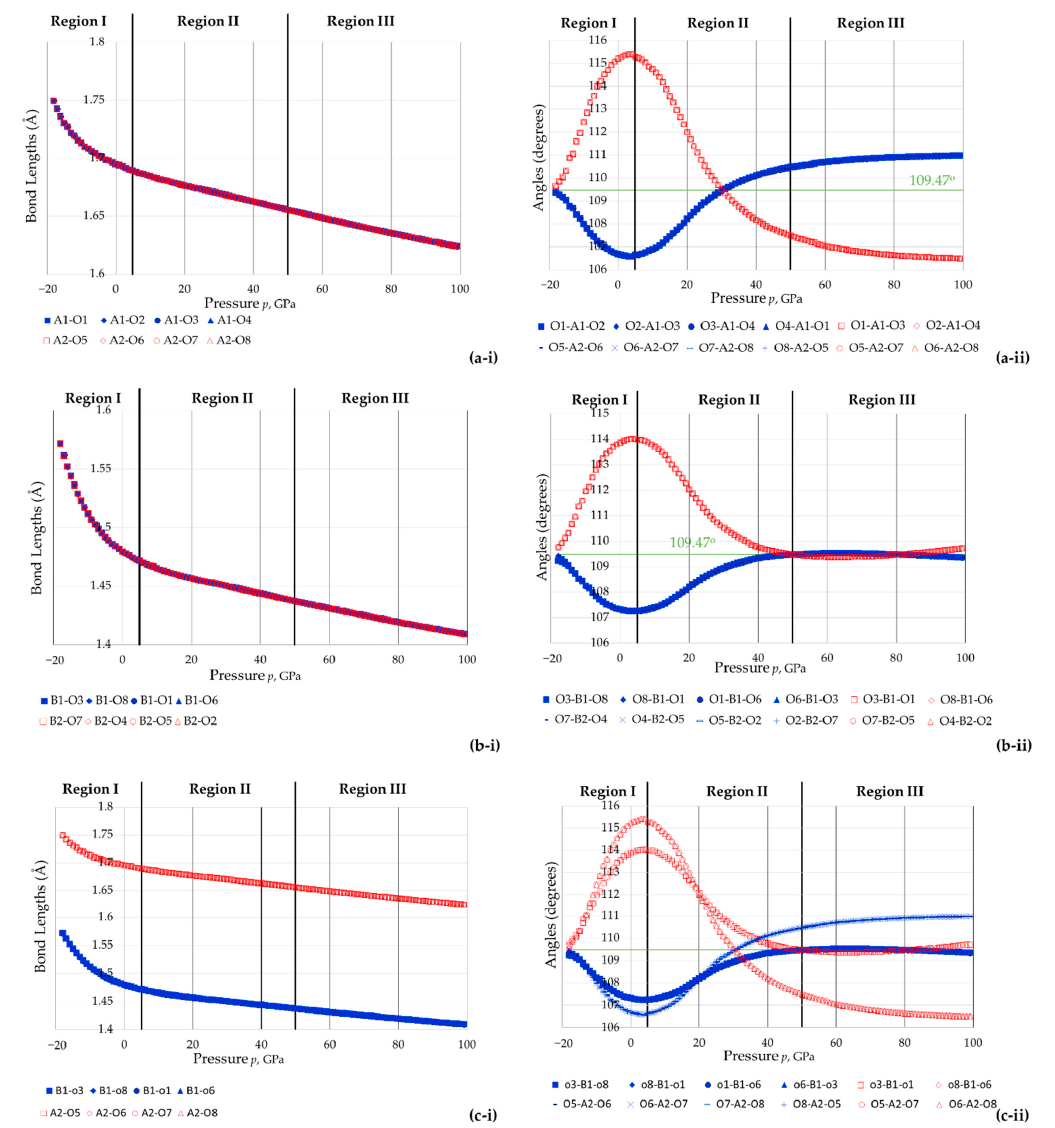
Figure 7. Data relating to ( a ) the two AsO 4 tetrahedra, ( b ) the two BO 4 tetrahedra, and ( c ) comparison of AsO 4 and BO 4 tetrahedra showing the variation in pressure of ( i ) bond lengths and ( ii ) bond angles.